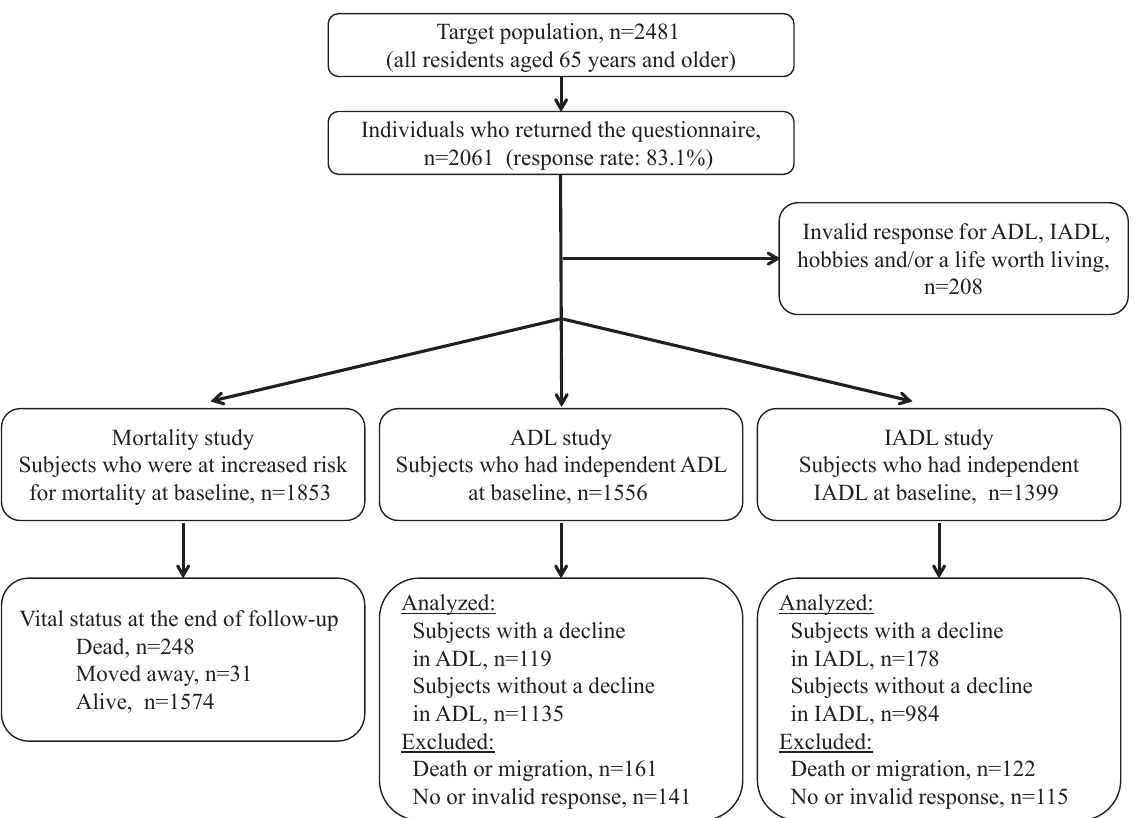
Figure. Flow diagram of the enrollment of study participants. ADL, activities of daily living; IADL, instrumental activities of daily